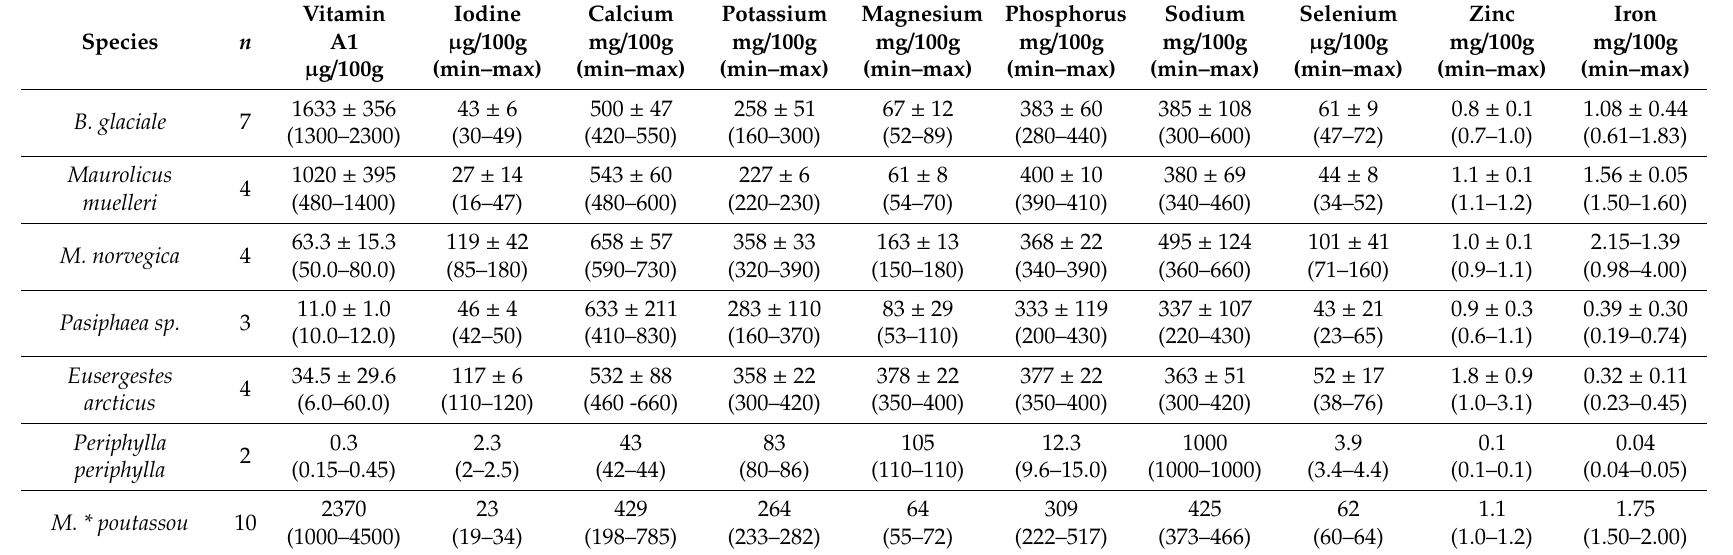
Table 3. Analytical wet weight-based values of vitamin A1, iodine and selected minerals in six mesopelagic species caught in three fjords in western Norway, and Blue whiting ( M. poutassou ) for